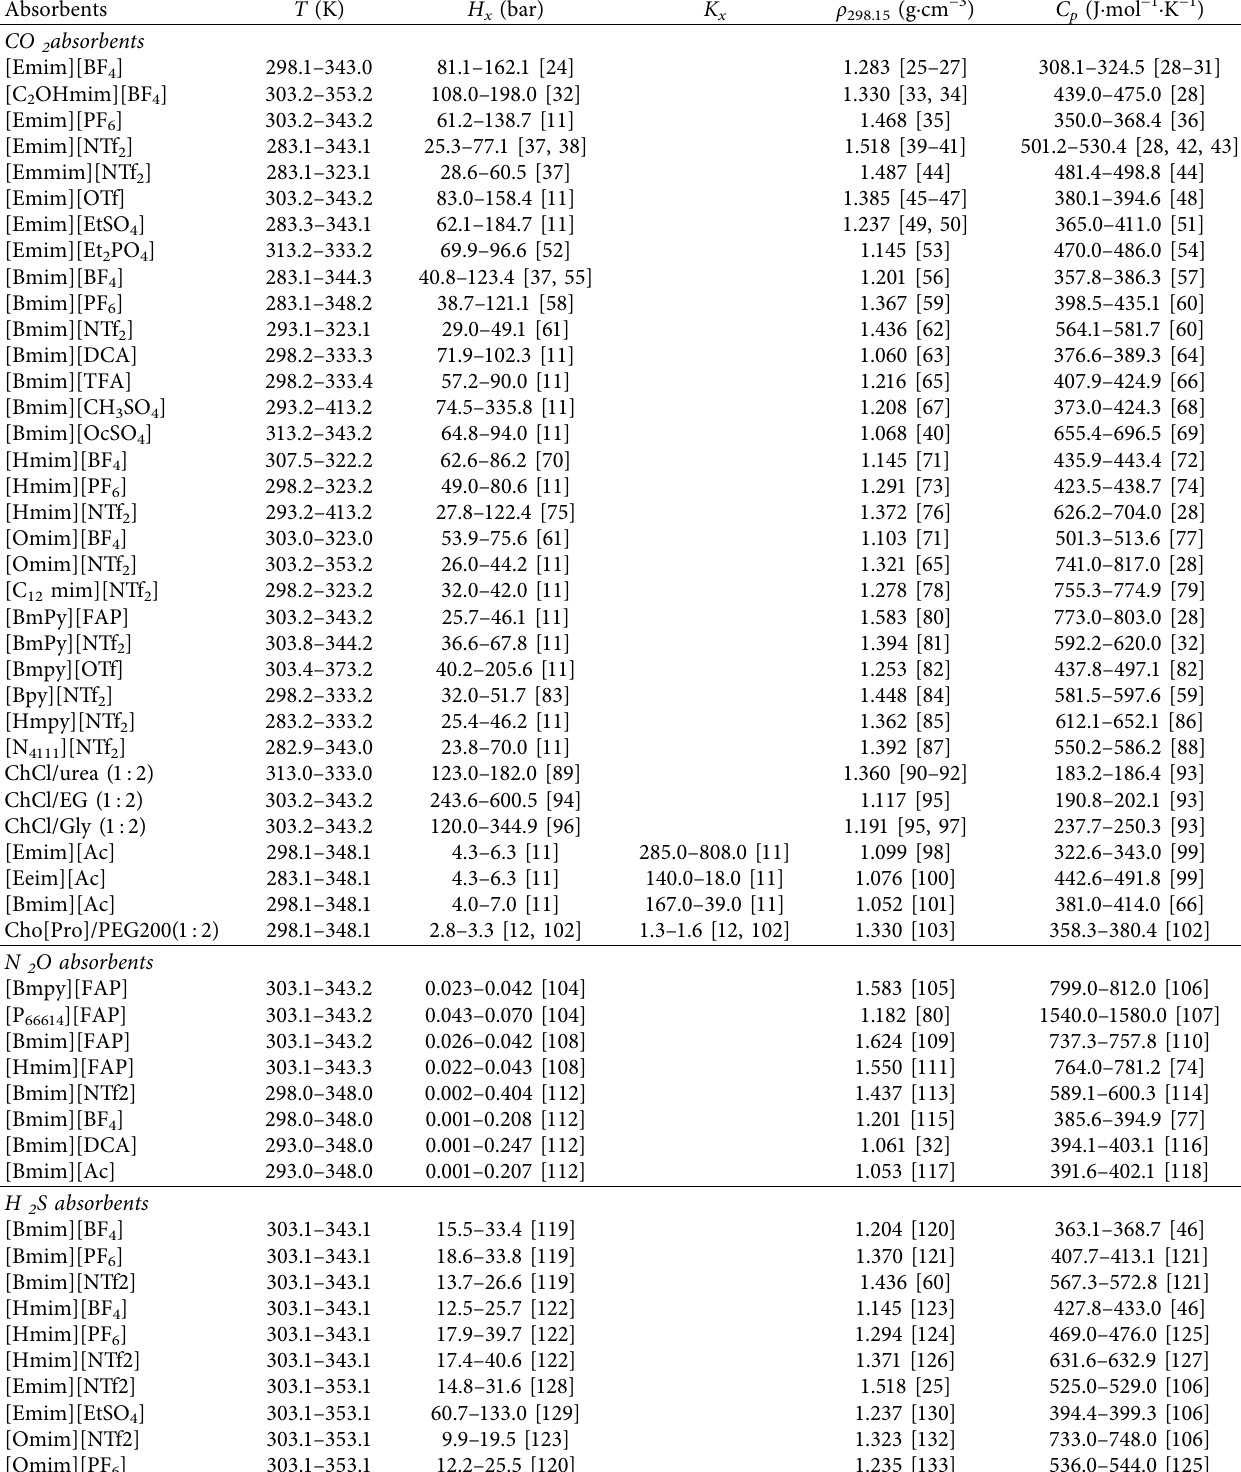
x ) in physical absorbents, the density at 298.15 K ( ρ 298.15 ), and the isobaric heat capacity ( C p ) of CO 2